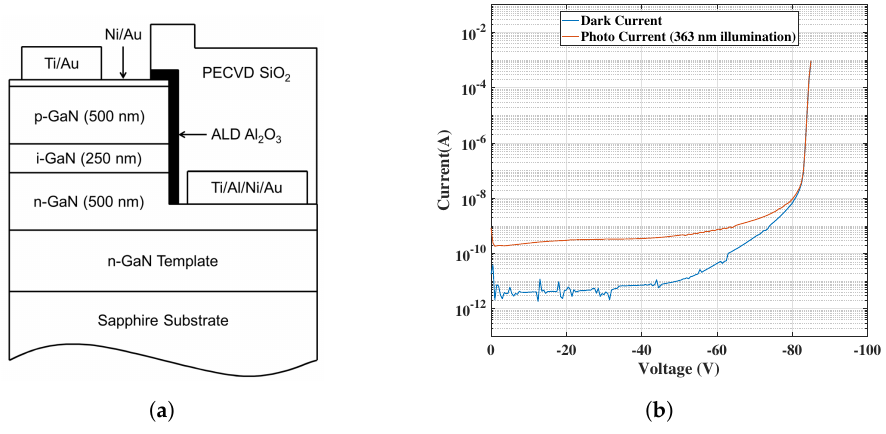
Figure 1. GaN APDs developed at JPL: ( a ) device geometry of a GaN APD used [4]; and ( b ) typical I–V characteristics (redrawn from